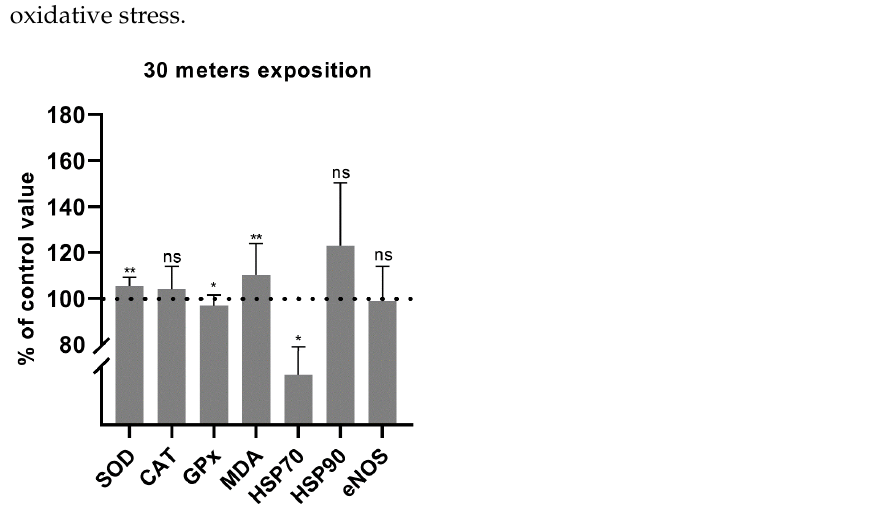
Figure 2 . Percentage changes in SOD, CAT and GPx activities and in MDA, HSP70, HSP90, and eNOS concentrations after 30 m exposure (* p < 0.05, ** p < 0.01, ns = p > 0.05).